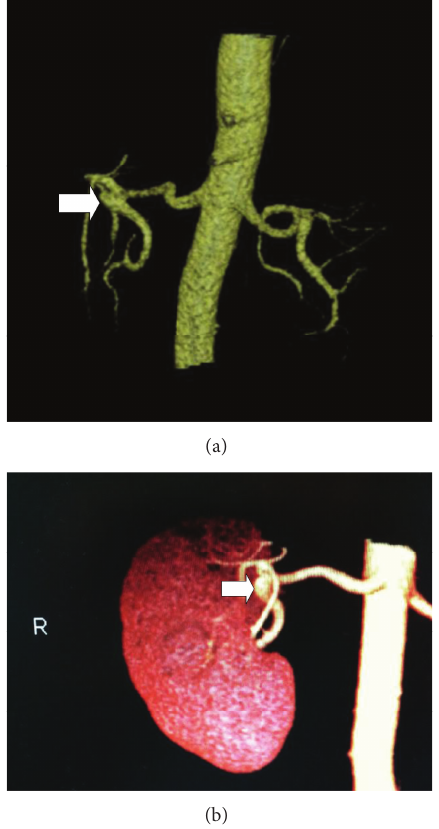
Figure 3: CT angiogram with 3D reconstruction shows a saccular aneurysm arising from the proximal right lower pole renal artery at the bifurcation of the main renal artery ( arrow